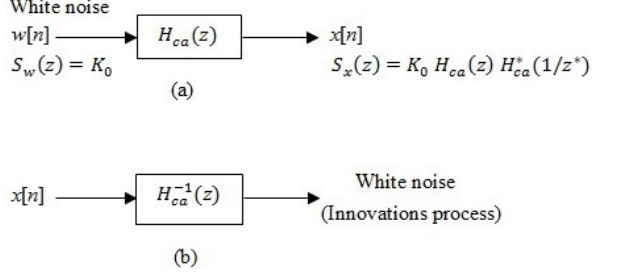
Figure 3. Innovations representation of a random process. ( a ) Signal model. ( b ) Inverse